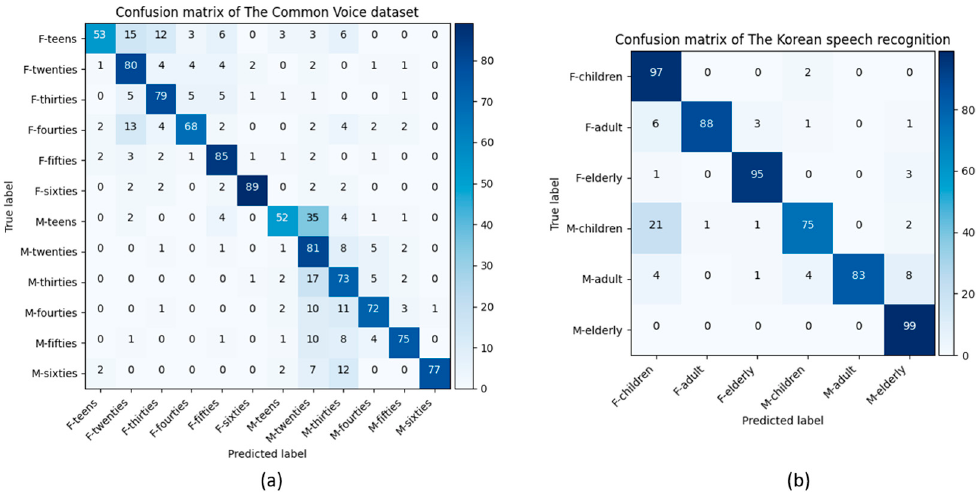
Figure 4. Obtained confusion matrices of the proposed model for the Common Voice ( a ) and the Korean speech recognition ( b ) dataset in age and gender classification with 75% and 90% average recognition rates. F and M denote the female and male genders, respectively.